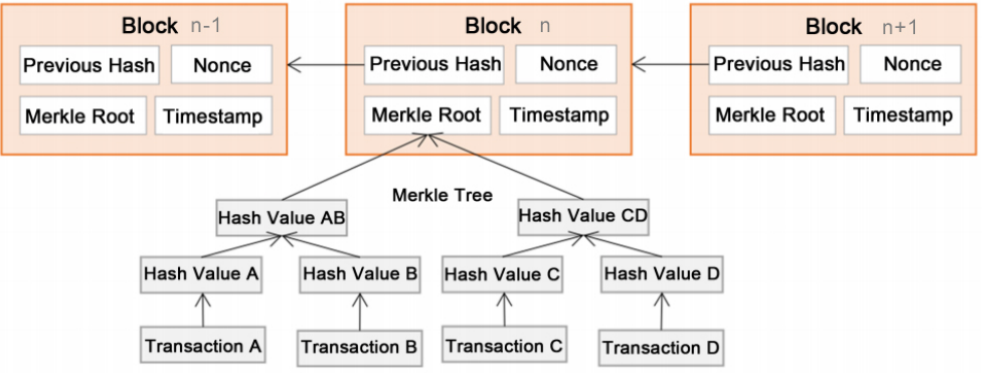
Figure 1. Typical blockchain